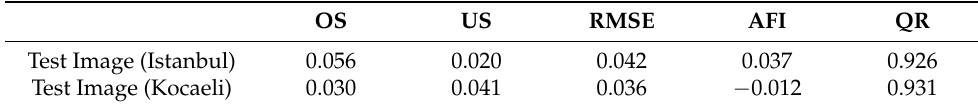
Figure 11. Samples of segmentation from Zurich Summer dataset. Red line refers to reference object; green line refers to MRS segments. Table 4. Segmentation quality metrics for Sentinel test dataset.